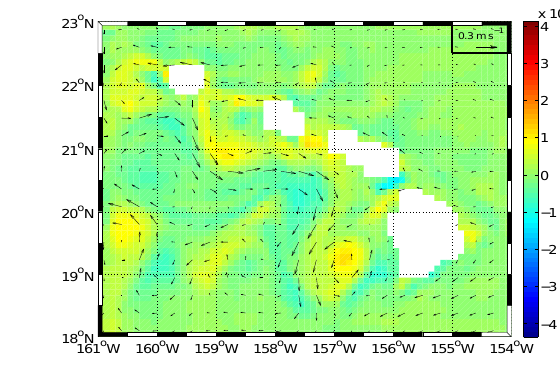
Fig. 4. Relative vorticity field with velocity vectors at 10-m depth on August 22 for Run-A (left) and Run-B (right).